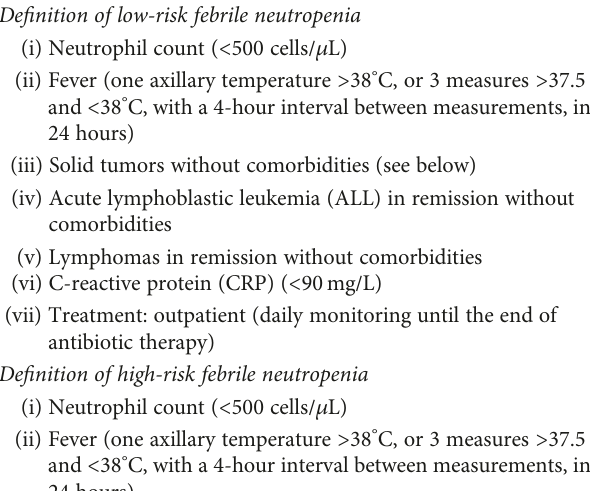
Table 1: De fi nition of febrile neutropenia and risk assessment model for serious